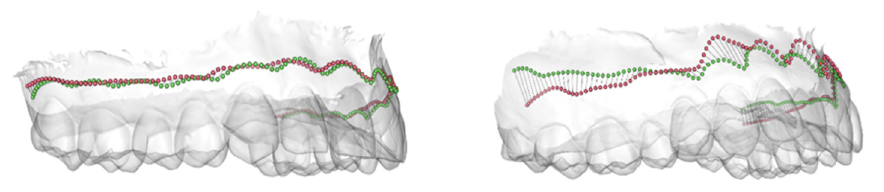
Figure 4. Best (left) and worst (right) prediction of the MG-BL of the maxilla based on the average error.